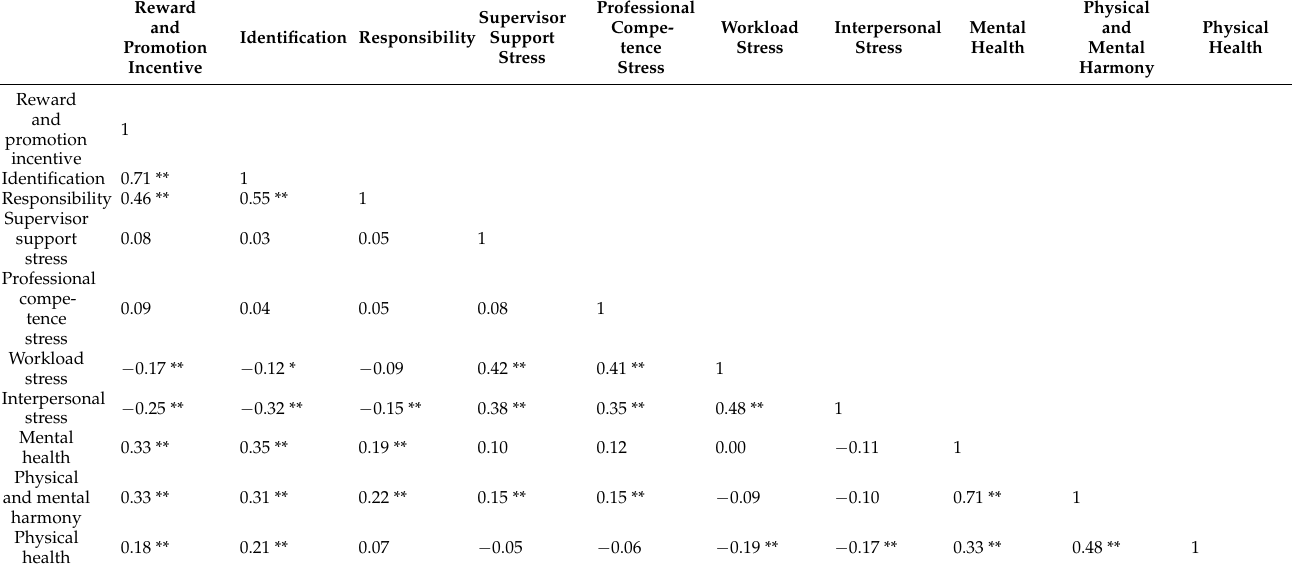
Table 4. Correlation analysis of wellness, organizational climate, and job stress in the hospitality industry. Reward and Promotion